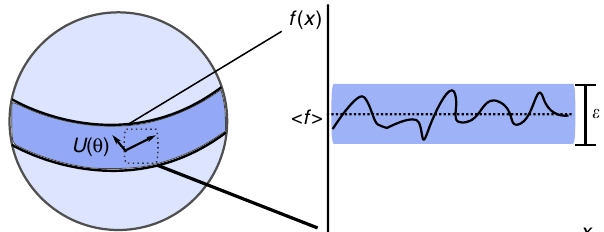
Fig. 1 Cartoon of concentration of quantum observables. The sphere depicts the phenomenon of concentration of measure in quantum space: the fraction of states that fall outside a fi xed angular distance from zero along any coordinate decreases exponentially in the number of qubits 40 . This implies a fl at plateau where observables concentrate on their average over Hilbert space and the gradient is exponentially small. The fact that only an exponentially small fraction of states fall outside of this band means that searches resembling random walks will have an exponentially small probability of exiting this “ barren plateau